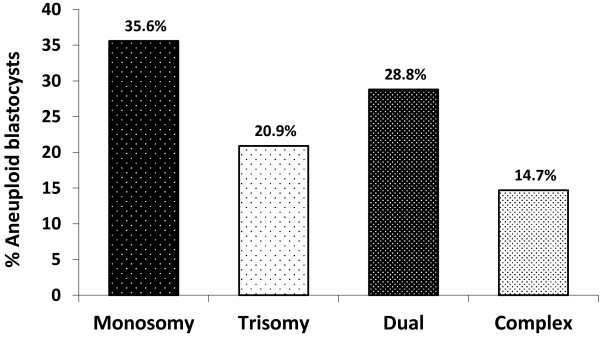
Detail of aCGH results derived from aneuploid blastocysts (n = 191) in the morphology assessment plus aCGH screening group. Monosomy = single chromosome loss; Trisomy = single chromosome gain; Dual = two chromosomal abnormality; Complex = three or more chromosomal abnormality.